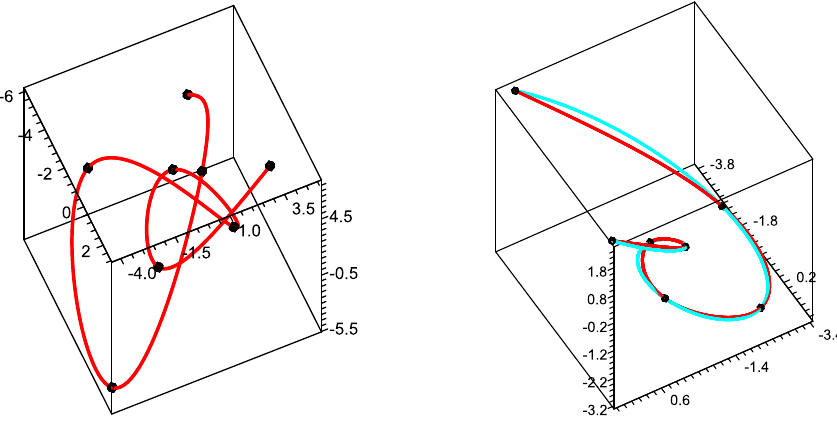
Figure 1. On the ( left ): The Bézier-spline curve C interpolates the list L . On the ( right ): The Bézier- spline curve C 1 (in red) interpolates the data points r ( t 0 ) , r ( t 1 ) , ..., r ( t 6 ) on the curve L 1 (in cyan). opts: axes=boxed, numpoints=2000, thickness=2, scaling=constrained